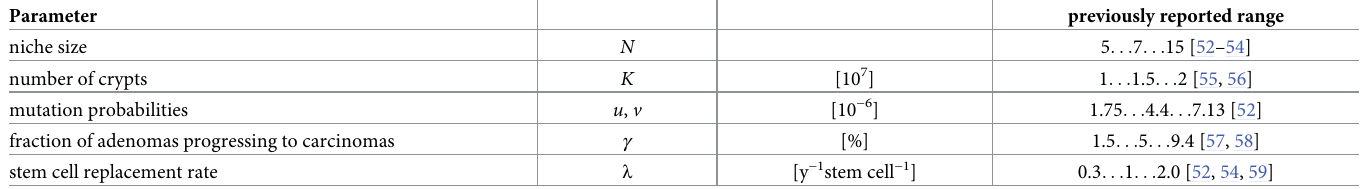
Table 1. Table of previously reported ranges of the parameters used in the niche model. The upper and lower boundaries as well as the expected value of each parameter K , v , u , or γ are used for the parameter variation, see gray lines in Fig 1, by which the effect of the parameter range on the prediction of the model is estimated. Parameter previously reported range niche